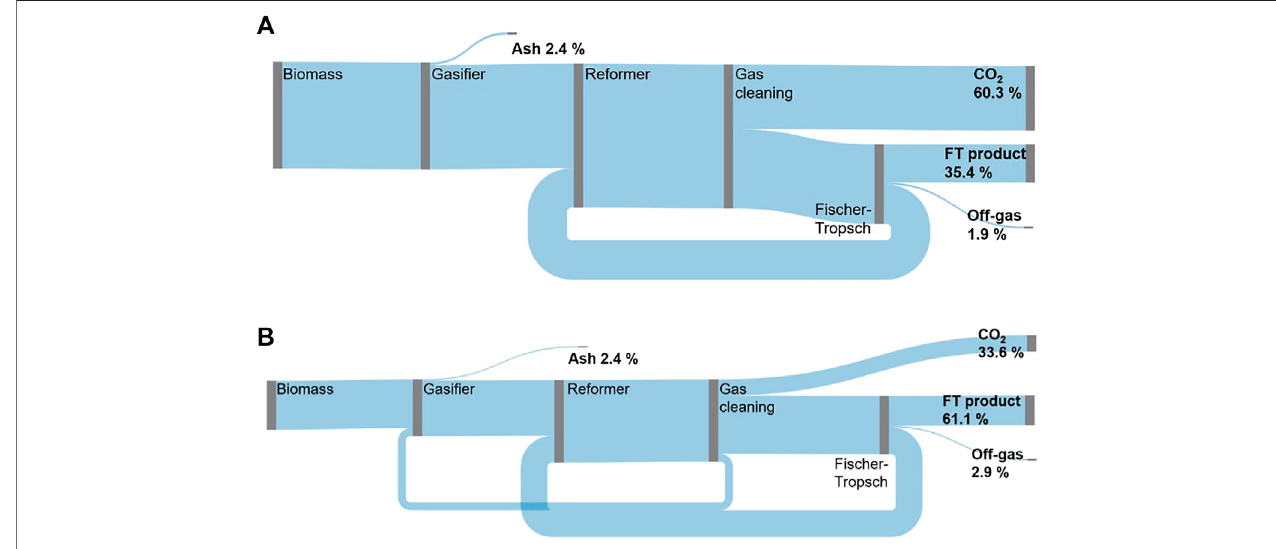
FIGURE 4 | Carbon fl ow Sankey diagram for case 1.1 BA mode (A) , EA mode (B) .